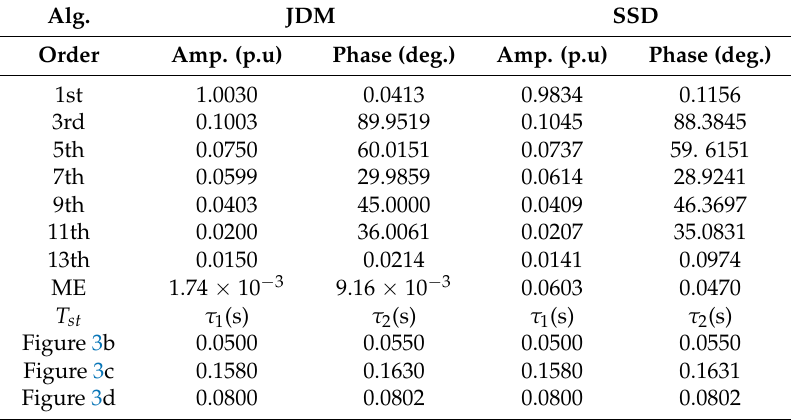
Alg.: Alg.: Algorithm .